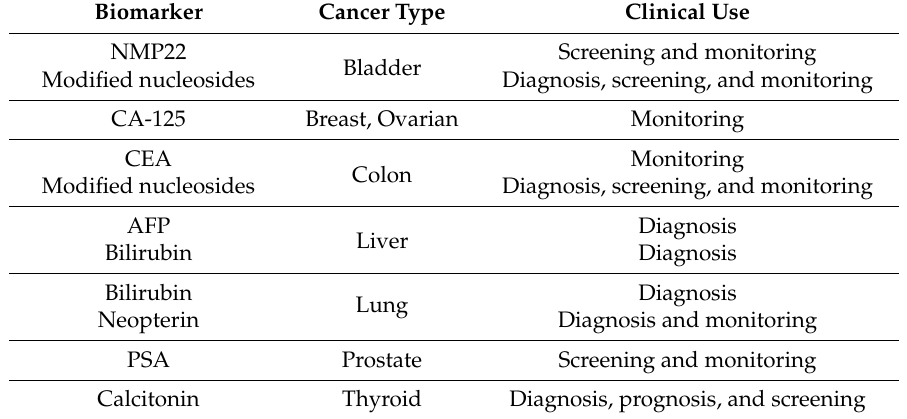
Table 1. The most common biomarkers used to detect different cancer types and their clinical